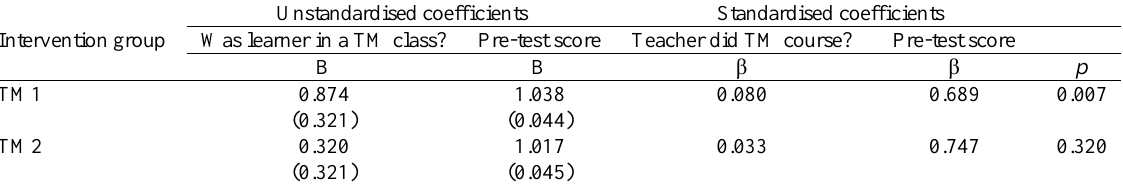
Table 5 Summary of separate regression analyses for the TM1 and TM2 in comparison to the control. Dependent variable: post-test score. Independent variables: ‘was learner in a TM class?’ and pre-test score. Standard error for unstandardised coefficients shown in brackets.